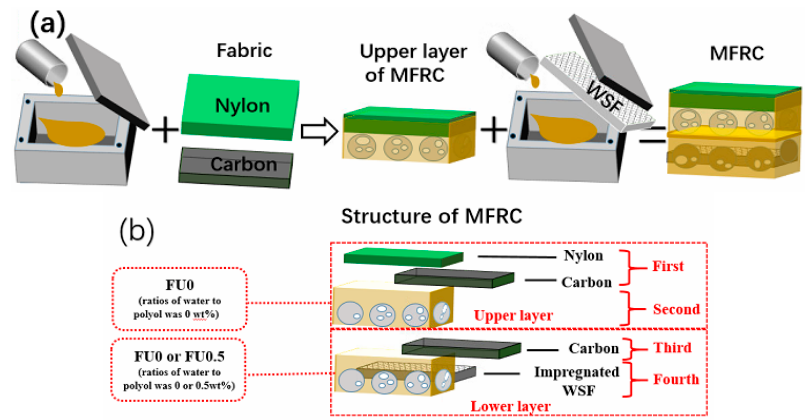
Figure 1. ( a ) Manufacturing process and ( b ) structural diagram of MFRCs.